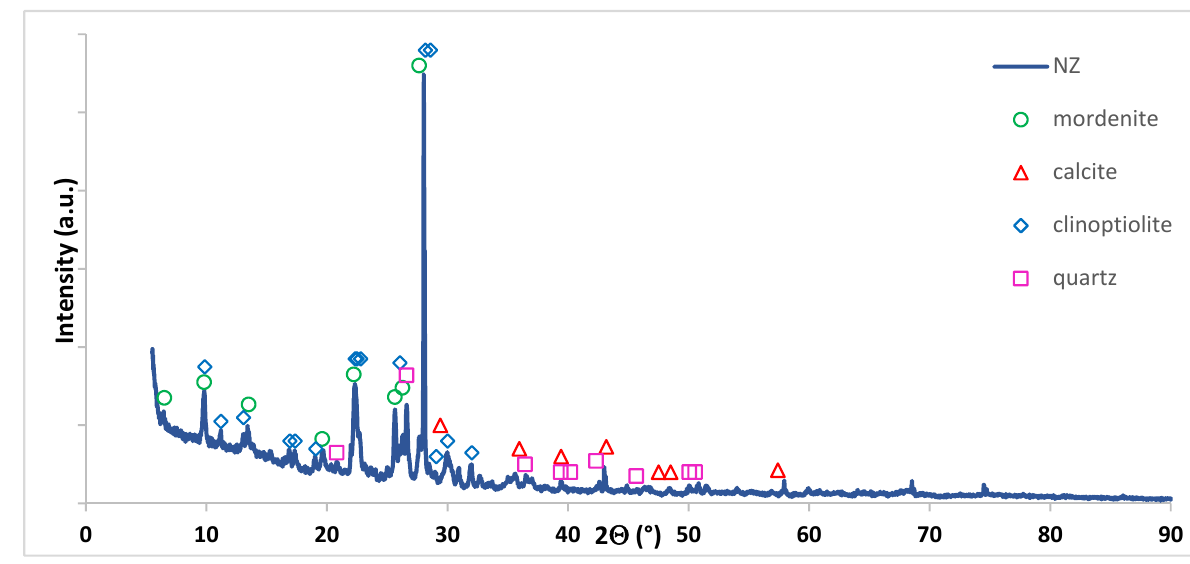
Figure 3. XRD diffraction curve of the natural zeolite.